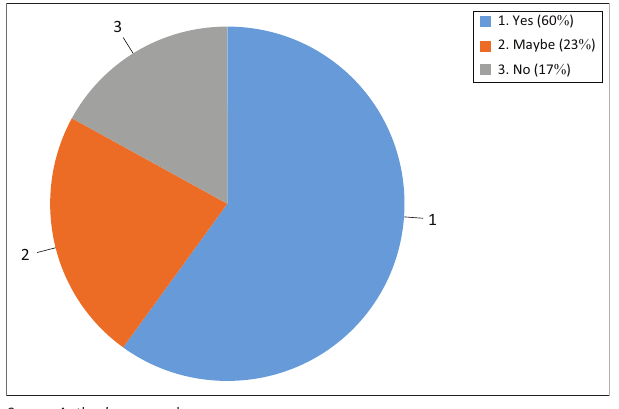
FIGURE 5: Students’ views on the efficacy of the multilingual strategies and interventions they have been exposed to: Do you think the current approach to multilingual education in the journalism programme is